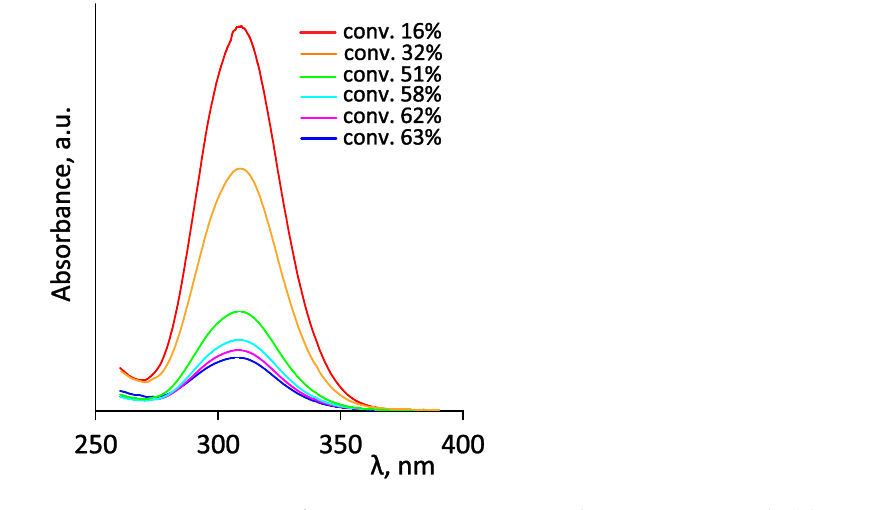
Figure 10. Photo-induced RAFT copolymerization of MPEGMA and AOEGMA for the synthesis of a diblock copolymer under blue light irradiation in THF. Under blue light (8.3 mW/cm 2 ), the first AOEGMA block reached a monomer conversion of 40% after 60 min, with M n,UV = 112,600 g/mol and a narrow molecular